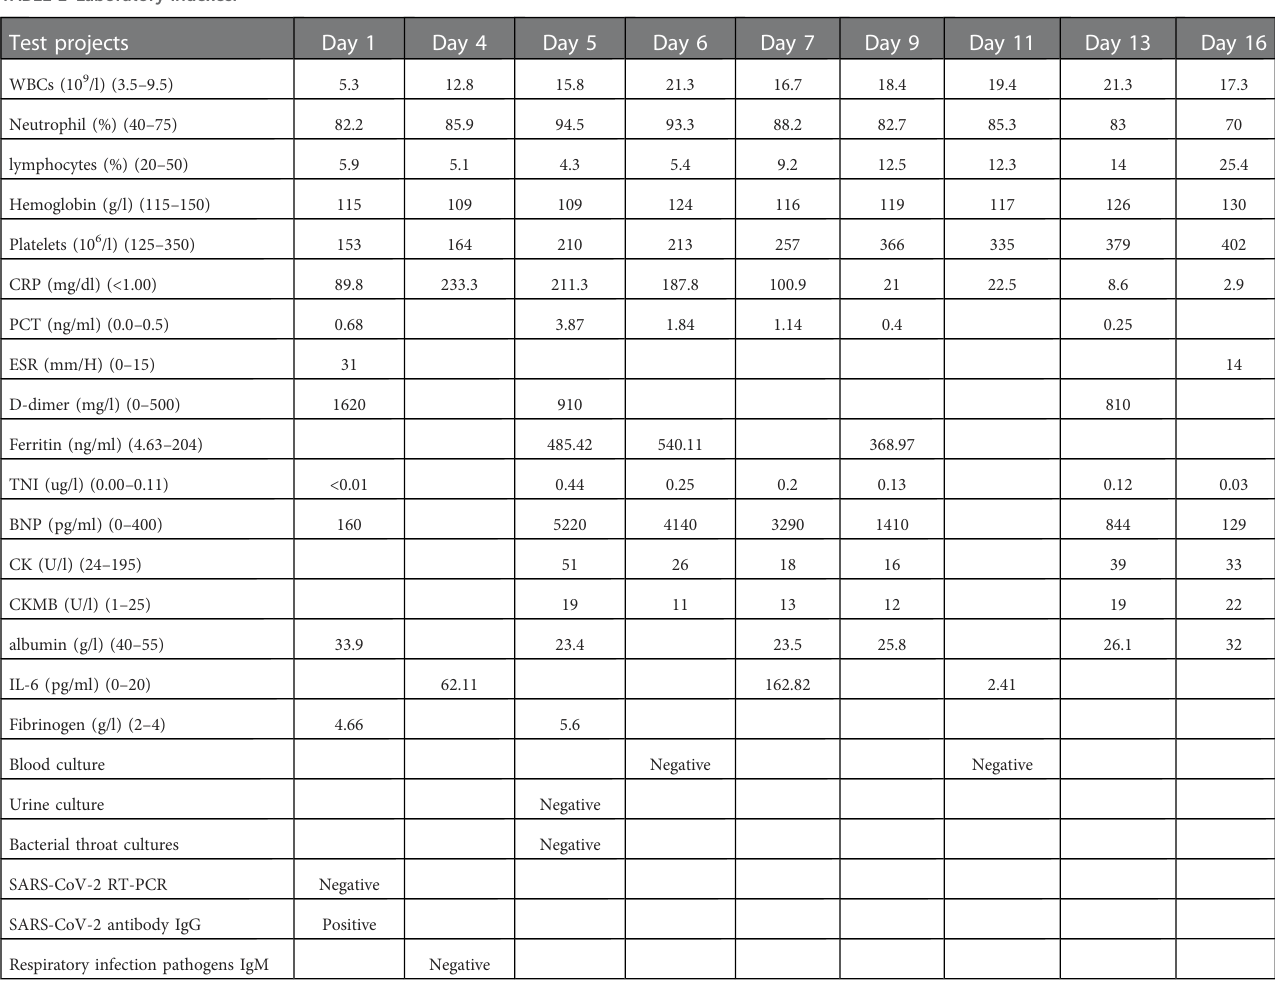
TABLE 1 Laboratory